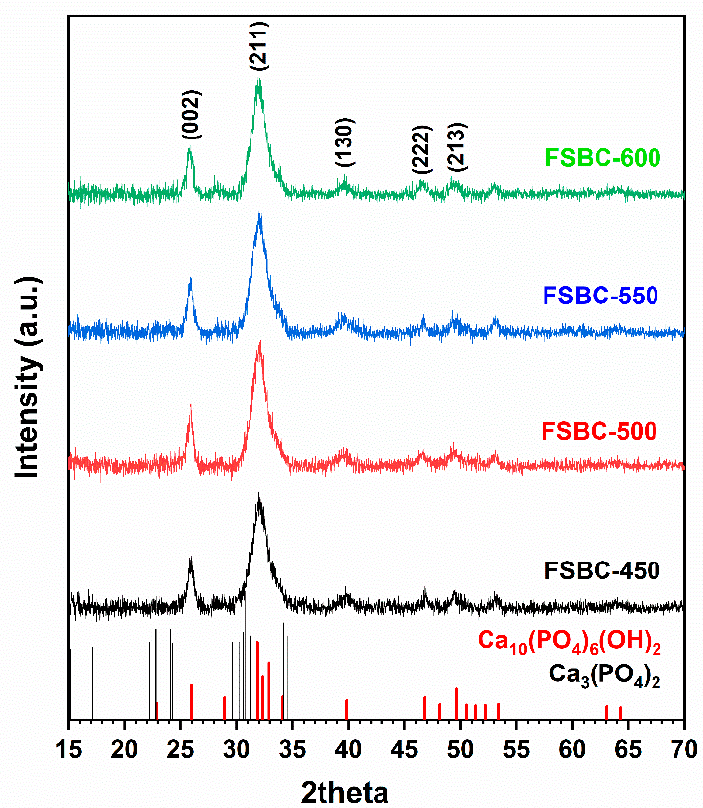
Figure 2. XRD patterns of the FSBC products that were derived from different pyrolysis temperatures. Table 2. Crystallite size, crystallinity index, BET specific surface area, and the area ratio of carbonate and phosphate bands from FTIR spectra of FSBC products.